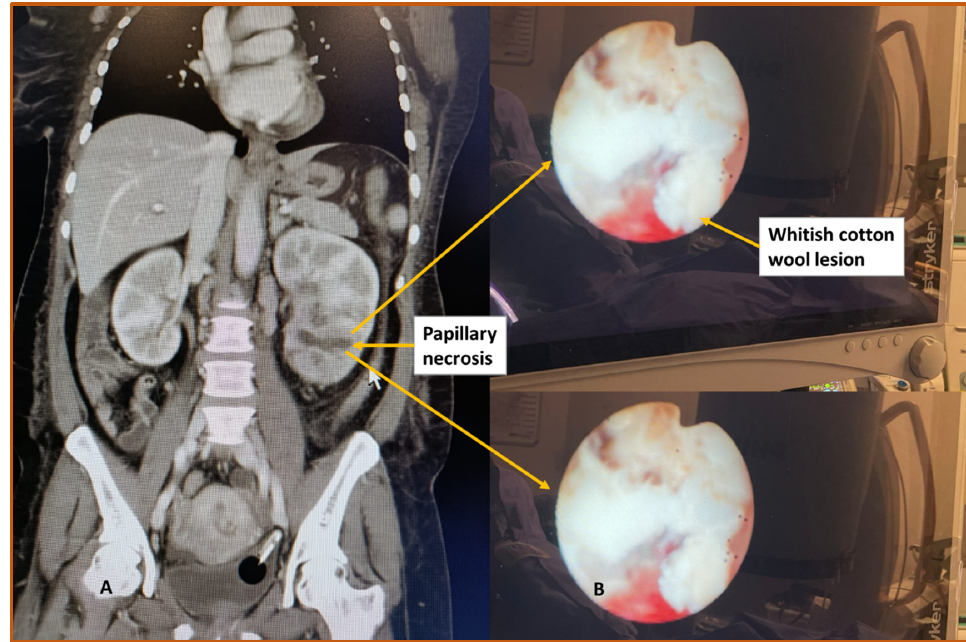
Figure 2. Features of renal papillary necrosis (RPN) in a 50-year-old female. ( A ) The computed tomography (CT) scan indicates spongiform lesion in a lower pole and posterior midpole regions. There are multiple small locules consistent with tubulo-interstitial nephritis or RPN. The patient was diagnosed with human immunodeficiency virus (HIV), pulmonary tuberculosis (TB) and immune reconstitution inflammatory response syndrome (IRIS); ( B ) the whitish cotton wool type lesion seen with flexible ureteroscopy in the lower pole of the left kidney.